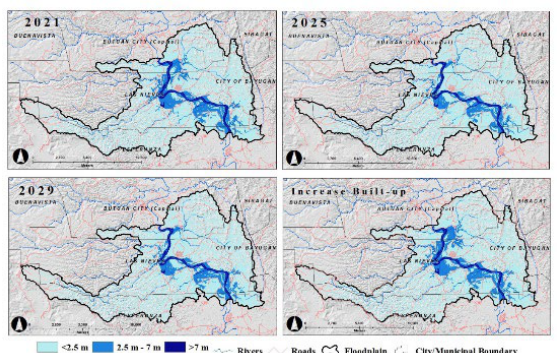
Figure 10. Flood depth maps with a 10-year rainfall return